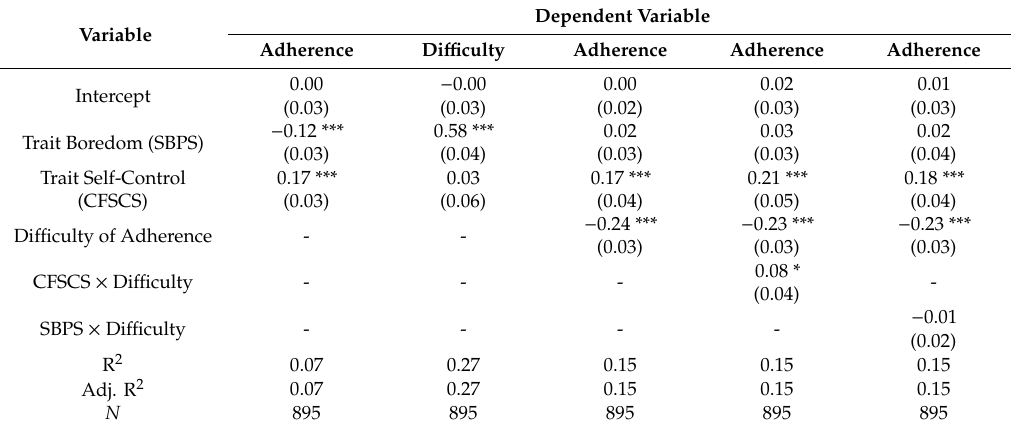
Table 2. Regression models investigating the mediating and moderating e ff ects of trait boredom and self-control on adherence to social distancing